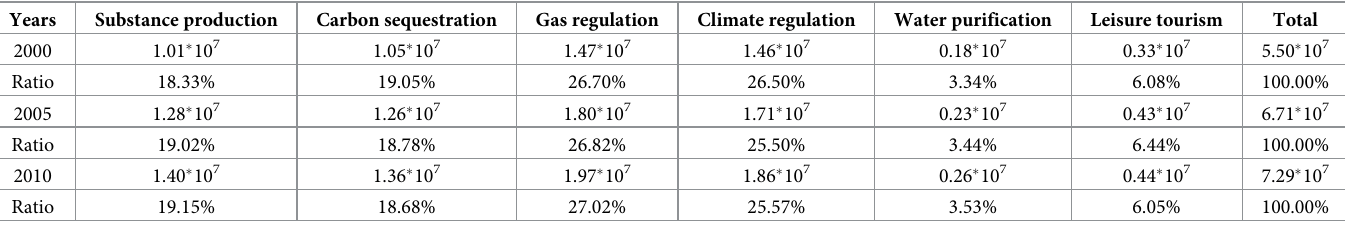
Table 5. The total economic values of different ecosystem services for different years (Chinese Yuan: RMB).